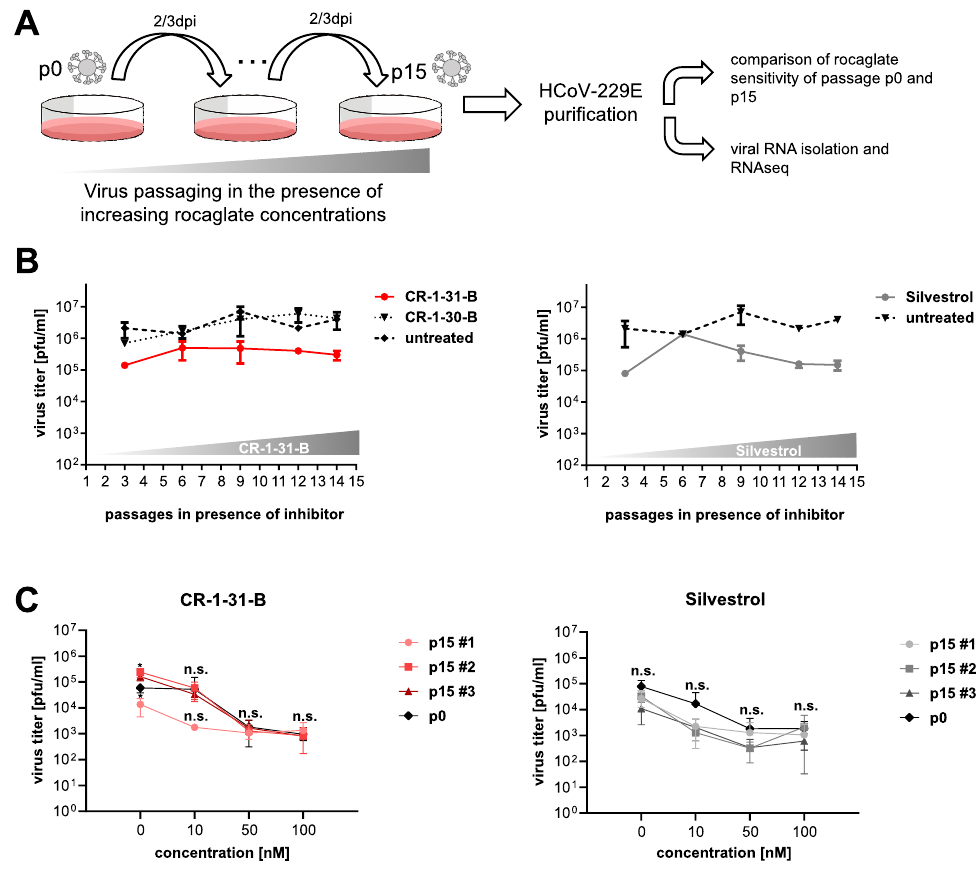
Figure 1. Passaging of HCoV-229E in the presence of increasing concentrations of rocaglates. ( A ) Schematic illustration of workflow. ( B ) MRC-5 cells were infected and treated as shown in ( A ) and titers were determined ( n = 3). Here, one representative passaging experiment out of three is shown. ( C ) MRC-5 cells were infected with plaque-purified HCoV-229E from p0 (non-passaged) to p15 (serially passaged, obtained as shown in panel B) at an MOI of 0.1 and treated for 24 h either at the indicated concentrations of CR-1-31-B or silvestrol or left untreated for the same time period. Viral titers were then determined using plaque assay ( n = 3). Significance levels compared to p0 were obtained using the unpaired t-test and are indicated as follows: * : p < 0.05; n.s.: not significant. Error bars show SD.